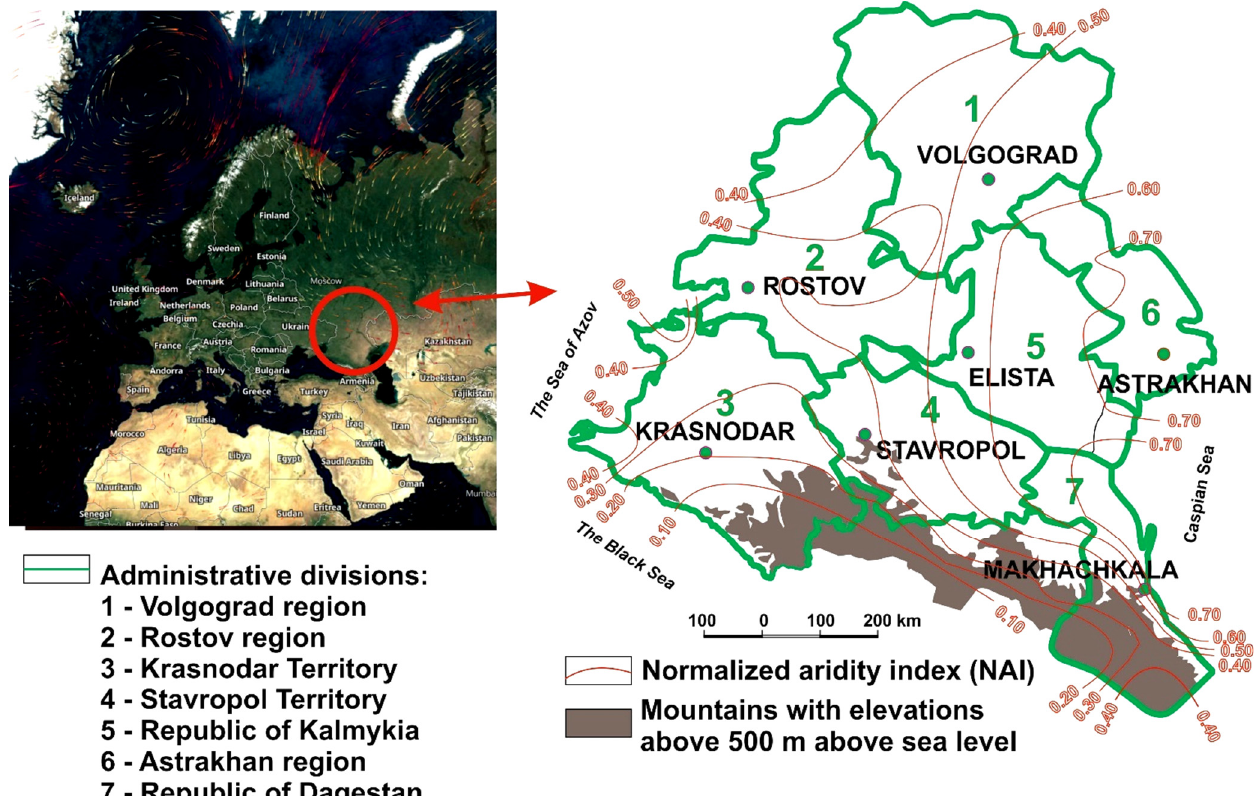
Figure 1. North-Western Near-Caspian region.